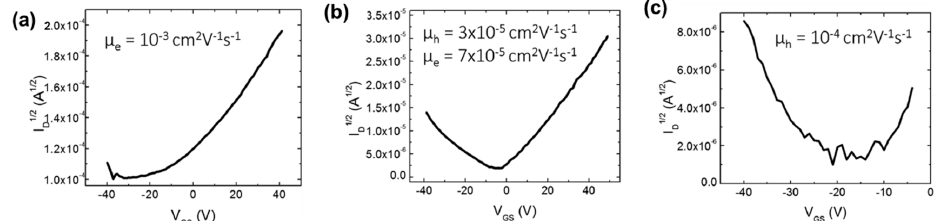
Figure 9. Electrical characteristics of the perylene-TCNQ crystals. ( a ) (perylene) 1 -(TCNQ) 1 with silver contacts (top contact); ( b ) (perylene) 2 -(TCNQ) 1 with silver contacts (bottom contact); ( c ) (perylene) 3 -(TCNQ) 1 with gold contacts (bottom contact). Data are reproduced with permission from [37]. Table 4. Performance of single-crystal field-effect transistors based on (perylene) 1 -(TCNQ) 1 , (perylene) 2 -(TCNQ) 1 and (perylene) 3 -(TCNQ) 1 .